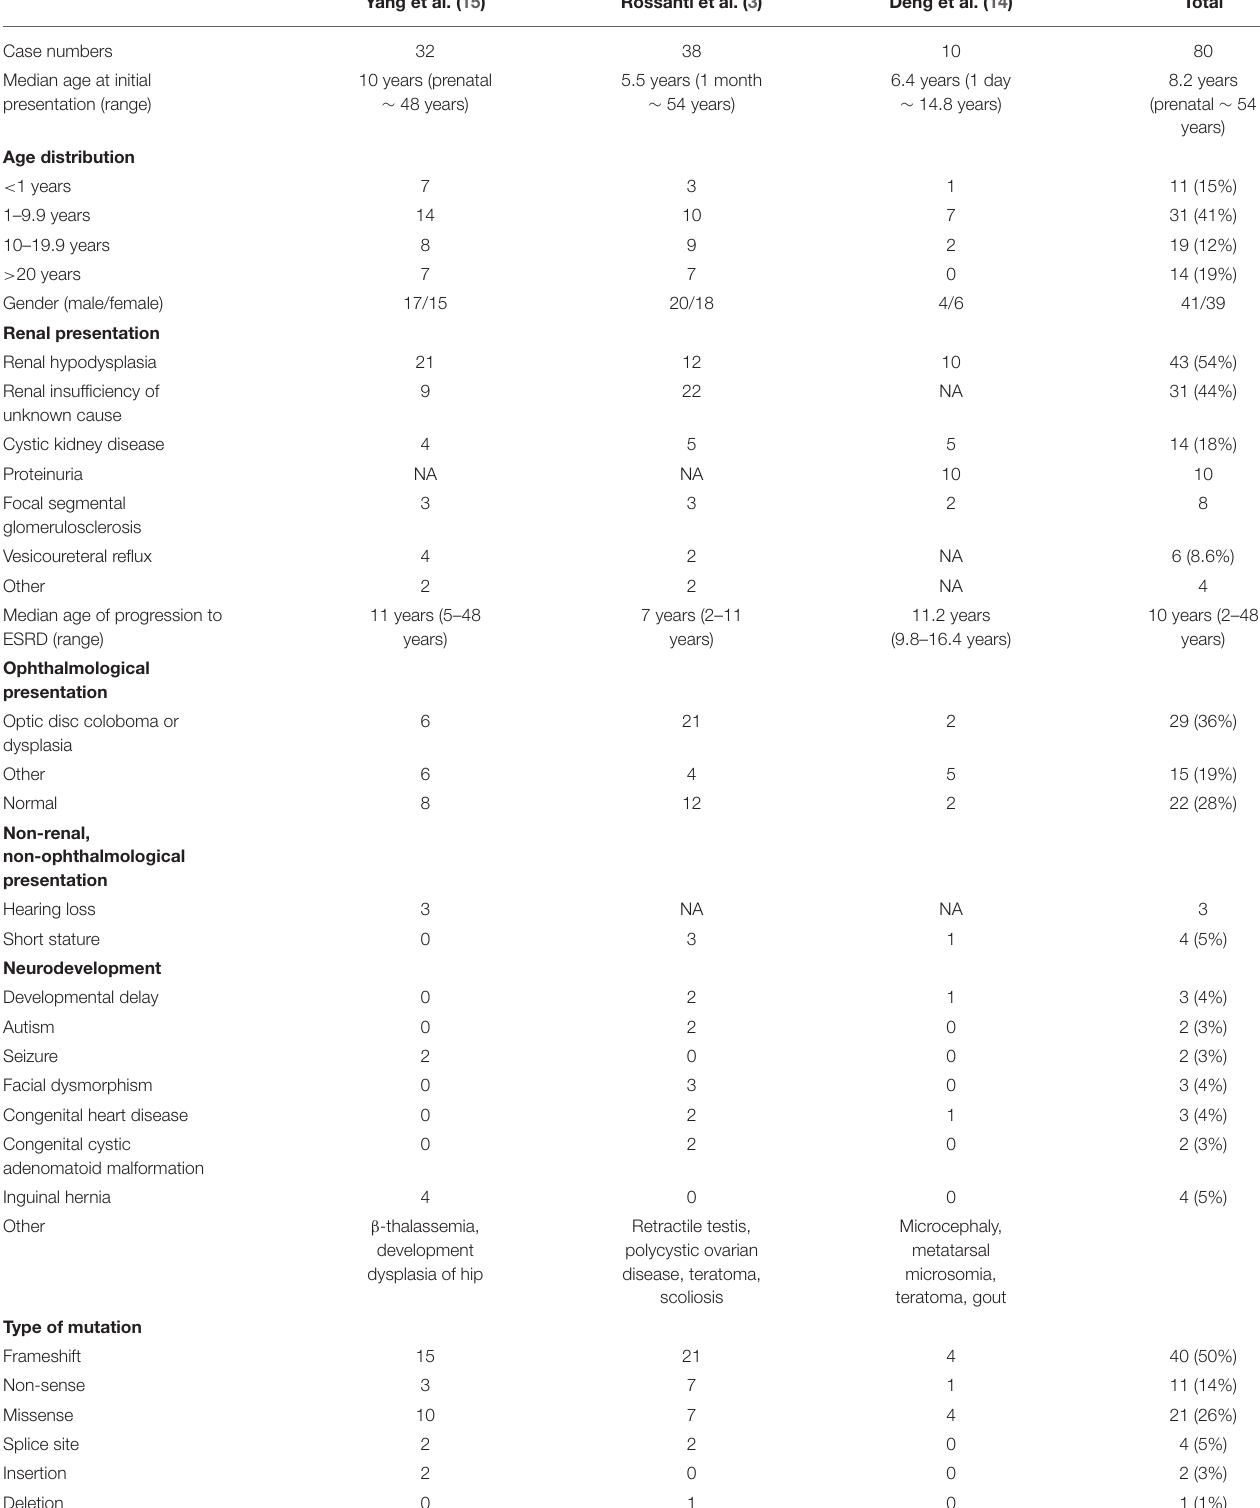
TABLE 2 | Summary of the clinical presentation and mutation type of previously reported cohort. Yang et al.